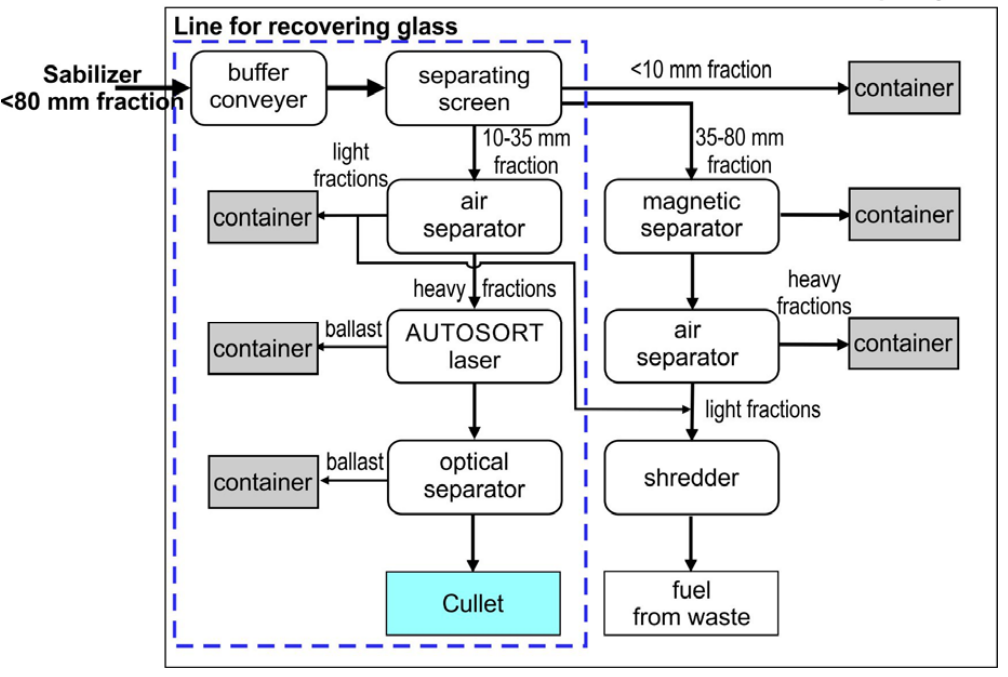
Figure 2. The technological diagram of the stabilizer processing line.